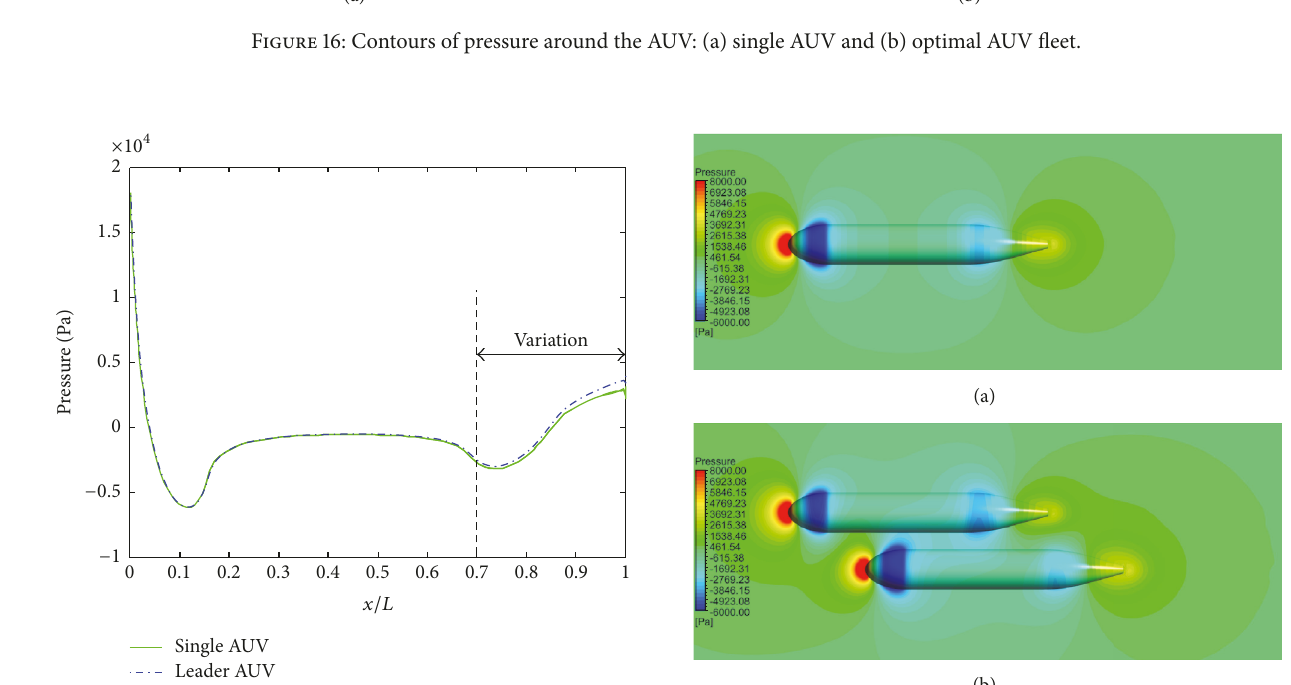
Figure 19: Contours of pressure around the AUV: (a) single AUV and (b) optimal AUV fleet.